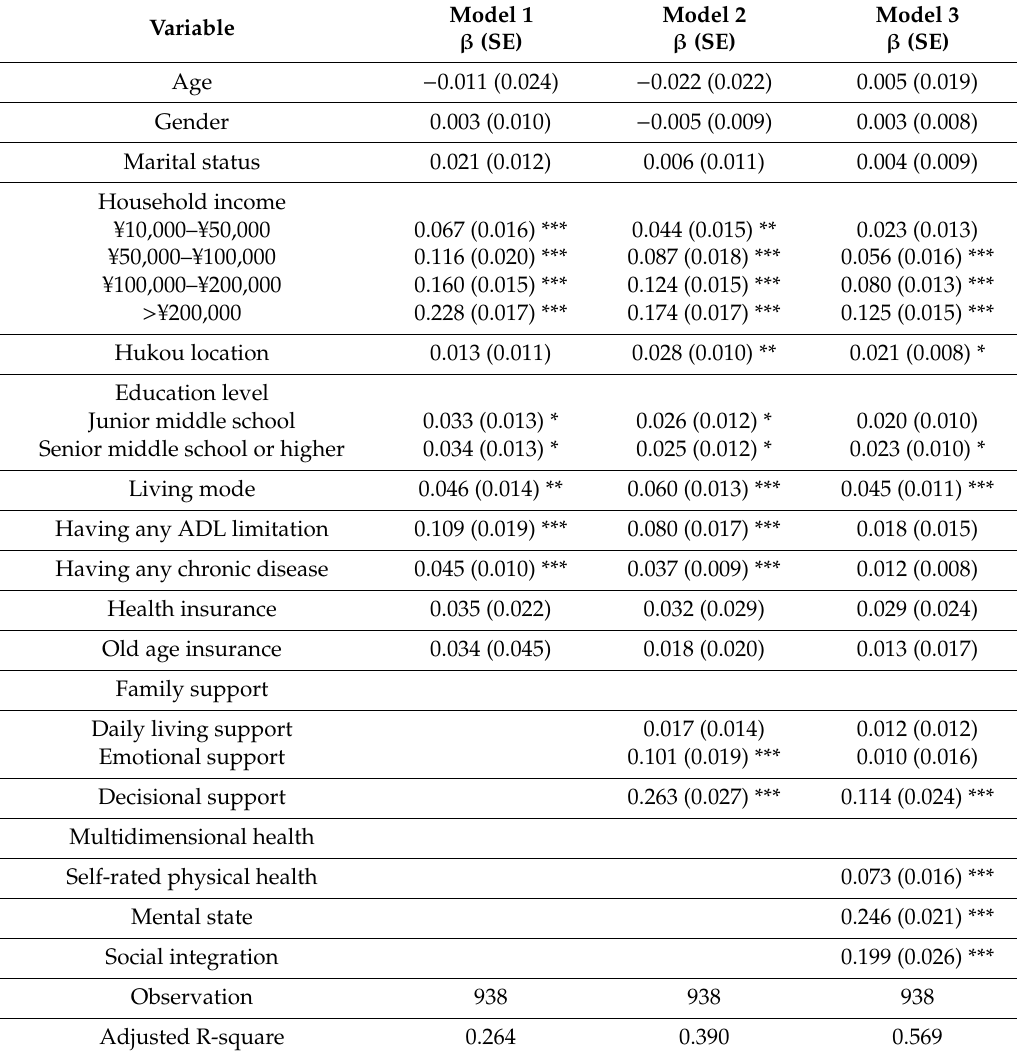
Table 4. Multivariate linear regression models of living